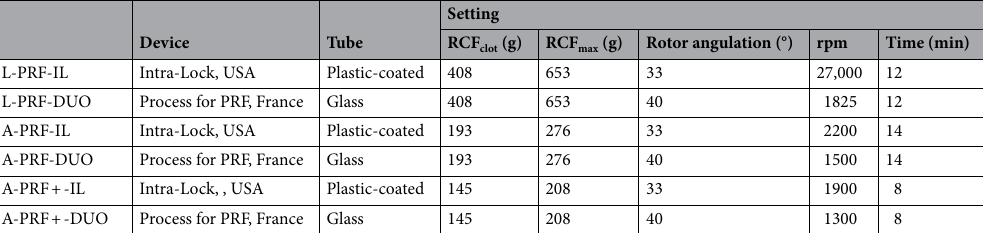
Table 2. Platelet rich fibrin matrices (L-PRF, A-PRF, and A-PRF +) prepared with the centrifuge process for PRF, Nice, France, (DUO)] and the Intra-Spin centrifuge [Intra-Lock, Biohorizons, Birmingham, Alabama, USA, (IL)] 7